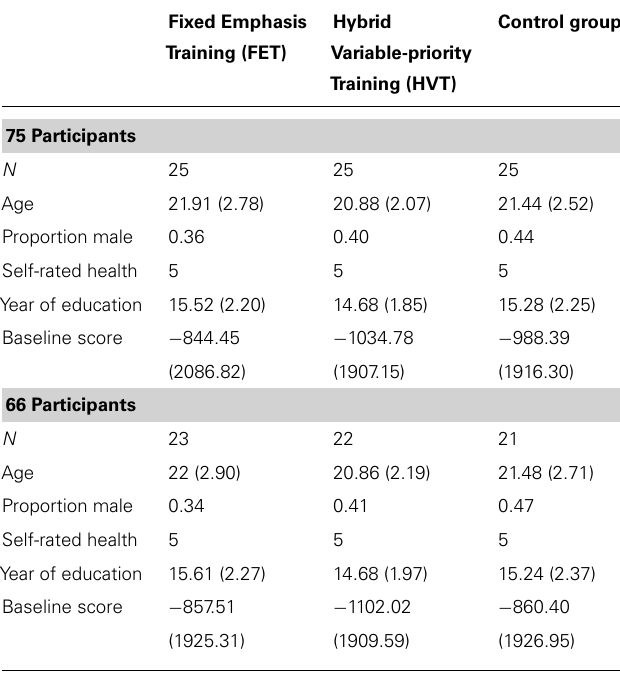
Table 1 | Descriptive characteristics of participants in the three training groups (FET, HVT, and control) based on all 75 participants and on the sample of 66 participants used for the analyses reported in this